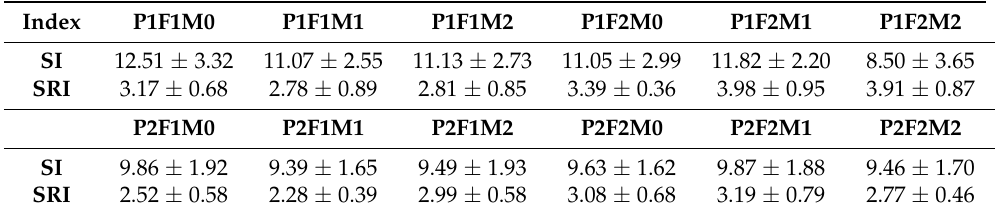
Table 2. Slenderness index (SI) and Stem:Root index (SRI) and their standard deviations for plants of one (P1) and two (P2) seasons of Nothofagus alessandrii under different treatments of fertilization (F1 and F2) and application of MFI (M0, M1, and